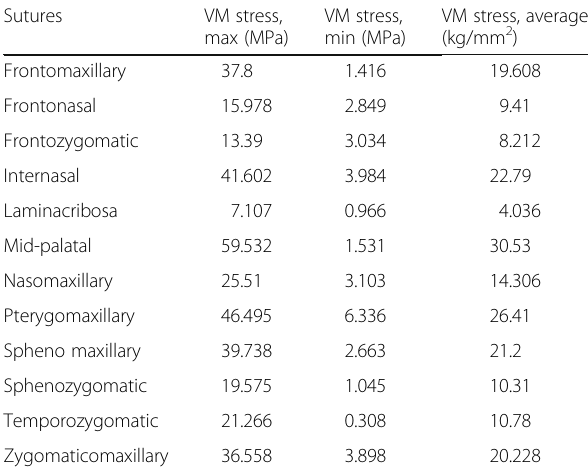
Table 3 Computational result of von Mises stress contours of the various sutural structures